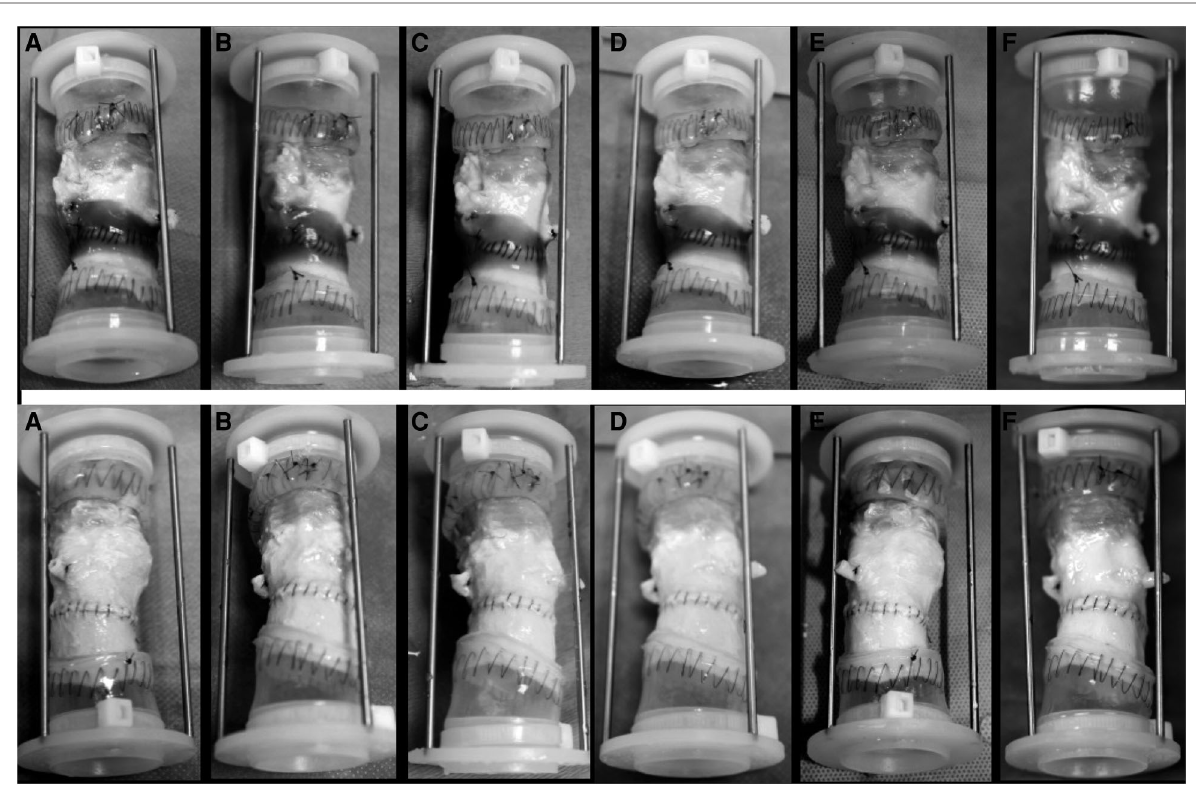
FIGURE 3 Images of the test group (upper row) and the control group (down) at 20 million cycle intervals. ( A ) 20 million cycles; ( B ) 40 million cycles; ( C ) 60 million cycles; ( D ) 80 million cycles; ( E ) 100 million cycles, and ( F ) 120 million